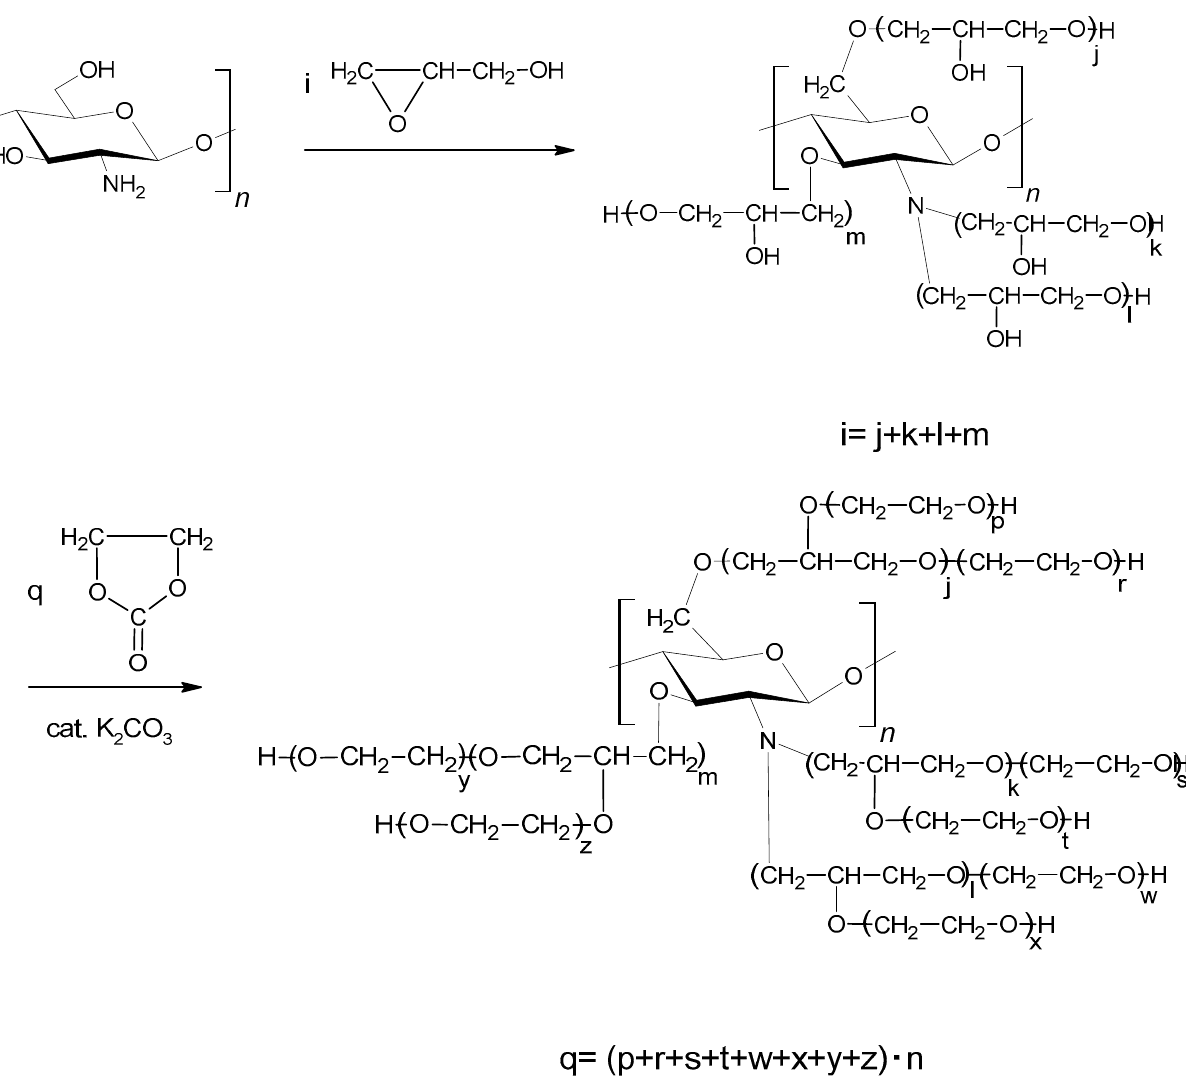
Table 1. Interpretation of MALDI-TOF spectrum of polyol (CS + GL) +